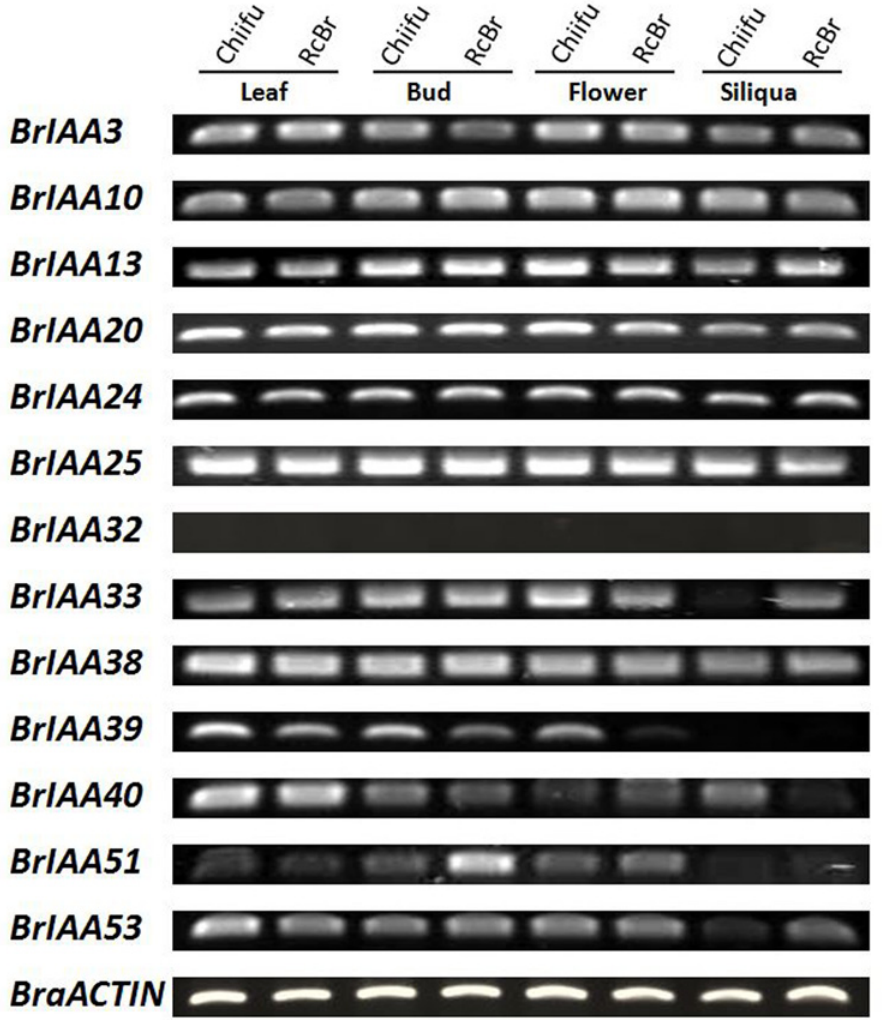
Fig 5. Expression of BrIAA genes in the different organs of ‘ Chiifu ’ and ‘ RcBr ’ lines were analyzed by semi qRT-PCR. BrIAA32 showed no expression in the any organ of ‘ Chiifu ’ and ‘ RcBr ’ . BraACTIN is used as